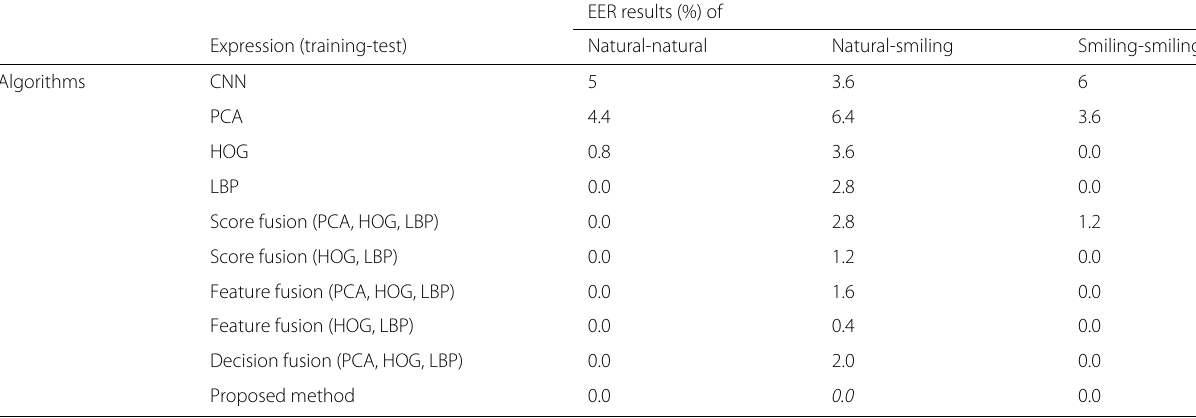
Table 3 EER results of expression-based experiments for non-twins EER results (%) of Expression (training-test) Natural-natural Natural-smiling